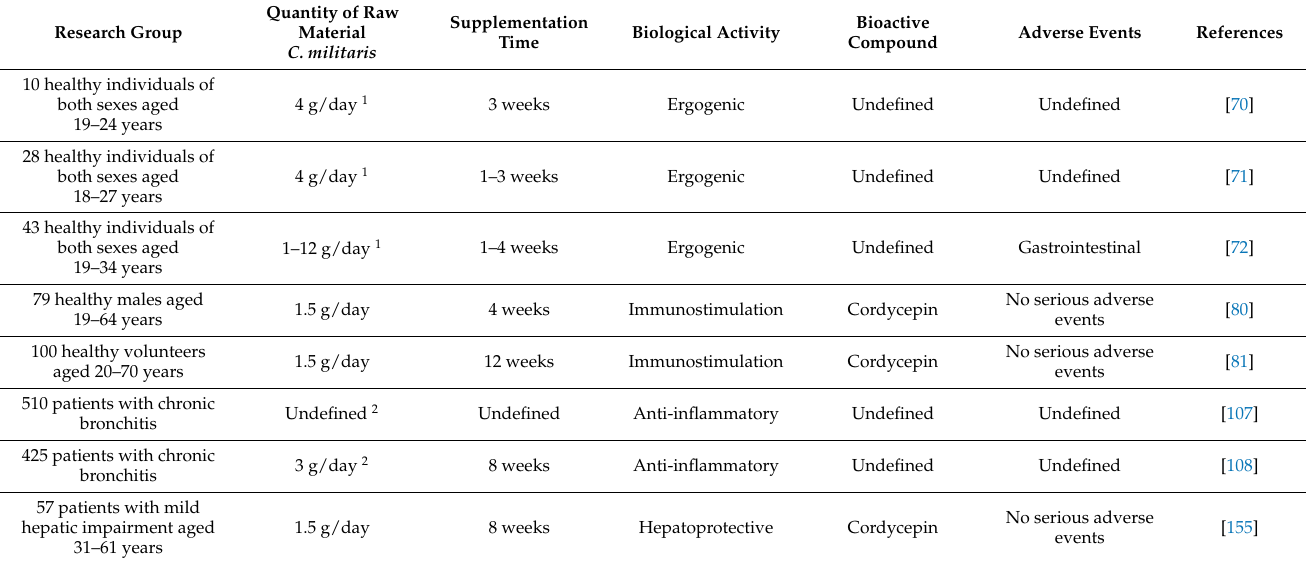
Table 2. Details of C. militaris research on human